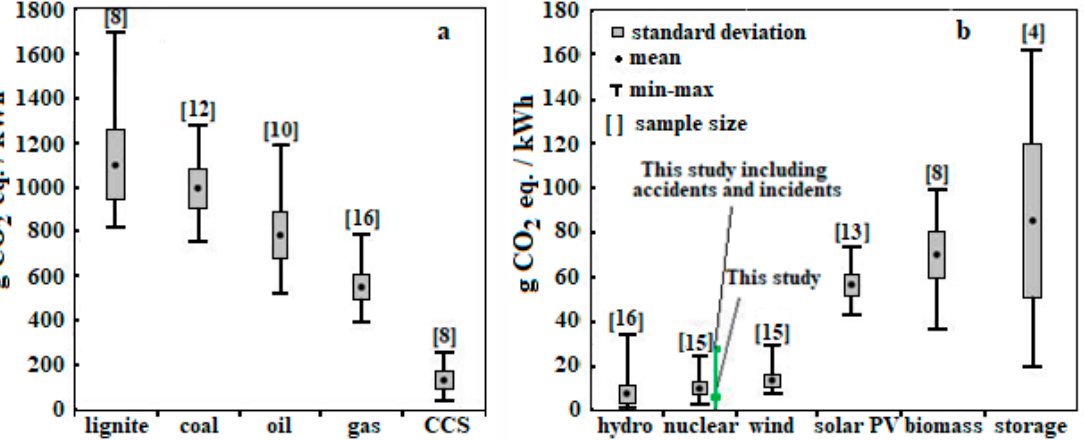
Figure 4. Results of life cycle GHG emissions from surveyed studies [32]. ( a ) fossil fuels; ( b ) renewables).